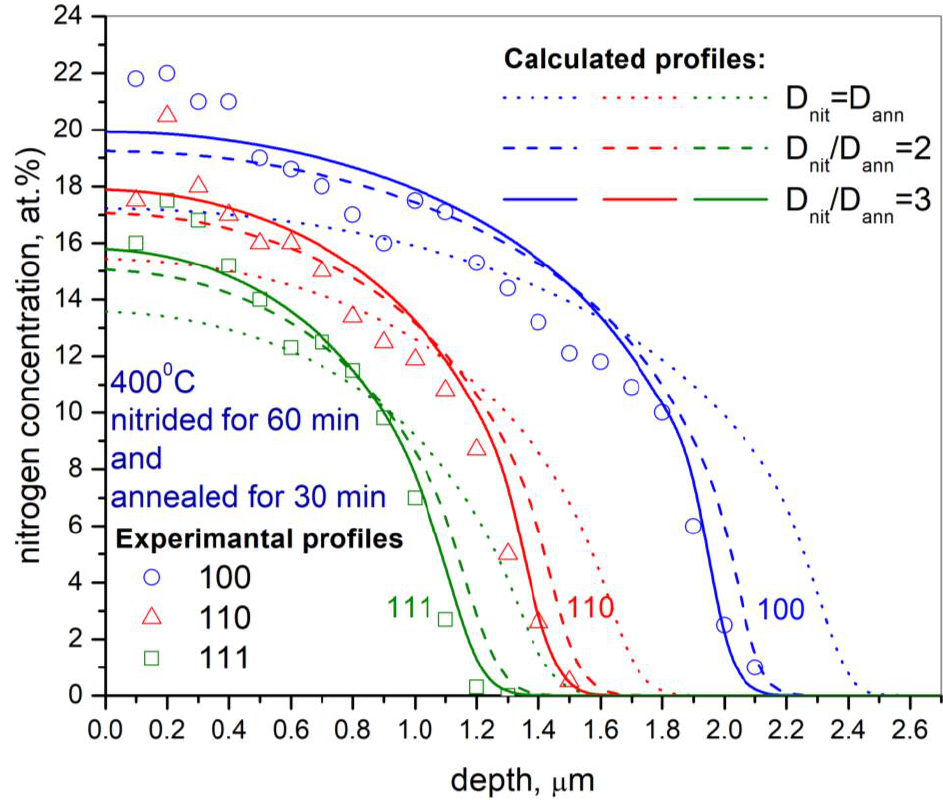
Figure 2. Calculated depth profiles of nitrogen in the (100), (110), and (111)-oriented single crystals of nitrided ASS after isothermal annealing (for 30 min at 400 °C). Experimental results (points) are taken from Ref. [53].